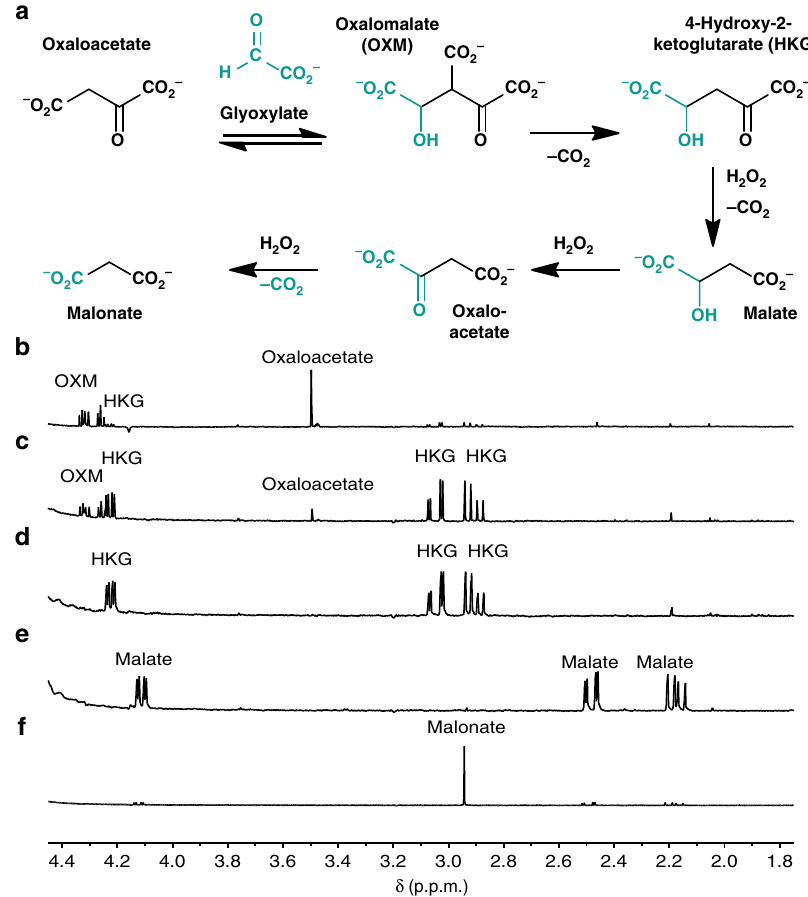
Fig. 4 Progression around the HKG cycle. a The reaction pathway of the HKG cycle. b 1 H NMR (in D 2 O) of a reaction aliquot from 90 mM oxaloacetate in 1.0 M aq. phosphate buffer, pH 7.0, with 1.2 eq. of glyoxylic acid, stirred at 23 °C for 5 min, c for 60 min, and d for 180 min. e A total of 2 eq. of H 2 O 2 was added and the reaction was stirred for additional 20 min. f An additional 15 eq. of H 2 O 2 was added and the reaction was heated at 50 °C for 24